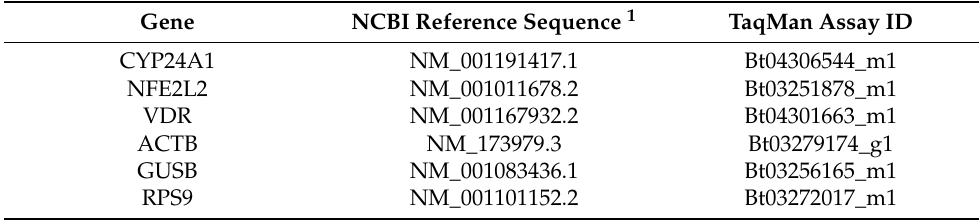
Table 1. Proprietary TaqMan primer reference